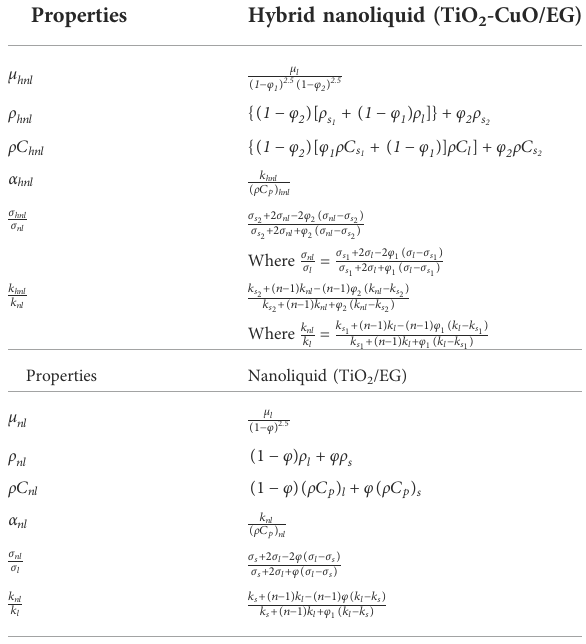
TABLE 2 Thermophysical properties of hybrid nanoliquid and nanoliquid Al-Mdallal et al.